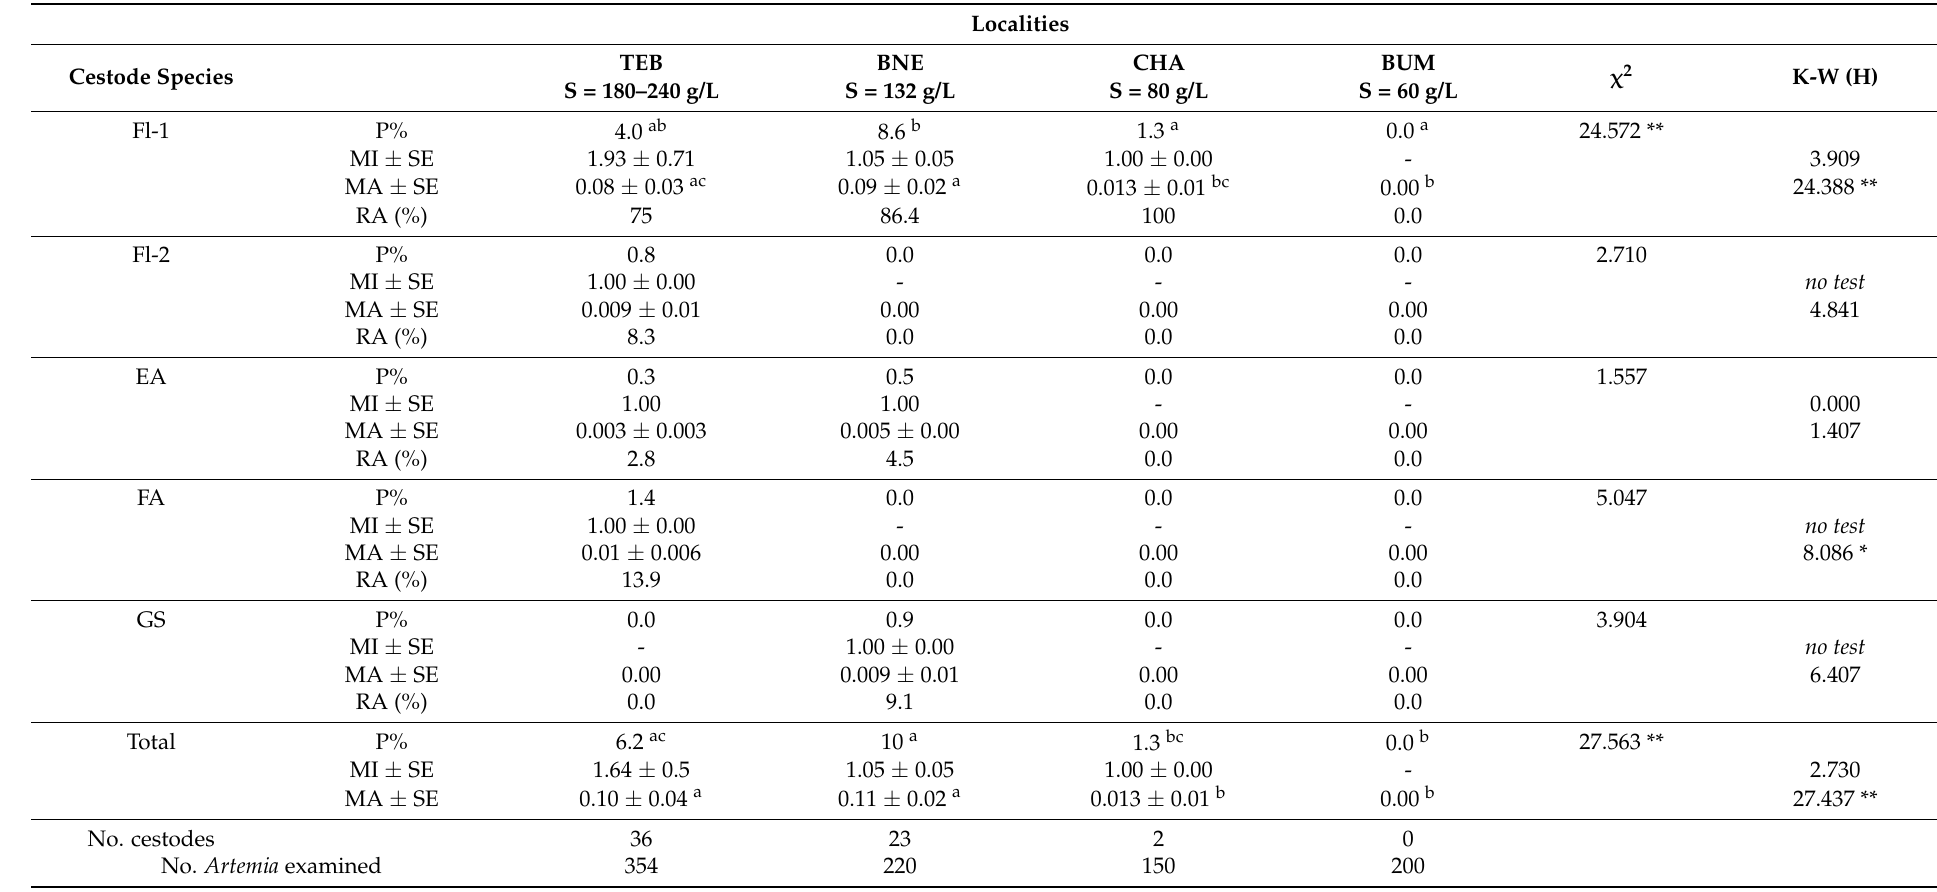
Table 3. Cestode infections in A. franciscana hosts from lagoons in Salar de Atacama in autumn 2018 (May/June). TEB, Tebenquiche lagoon; BNE, Barros Negros lagoon; BUM, Burro Muerto pond; CHA, Chaxas lagoon. S, salinity. P%, prevalence; MI, mean intensity; MA, mean abundance; SE, standard error; RA (%), relative abundance. Abbreviations corresponding to cestode species are explained in the text. Differences among localities were tested by Chi-squared or Fisher ´ s exact test (for prevalences) and Kruskal–Wallis test (H-W, for intensities and abundances). Different superscript letters denote statistical differences after Post Hoc procedures with Bonferroni correction for multiple